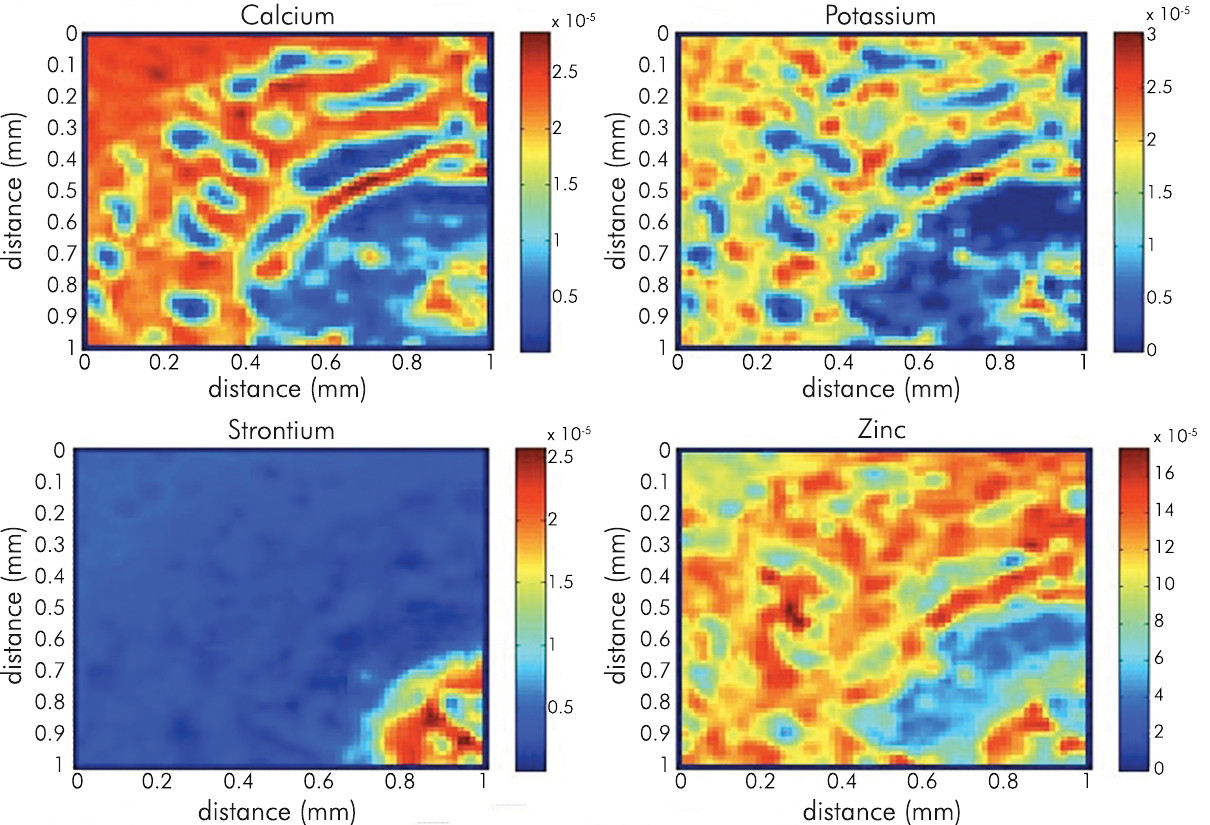
Figure 7. µXRF-SR spatial distribution of strontium from SrHA microspheres after 30 days